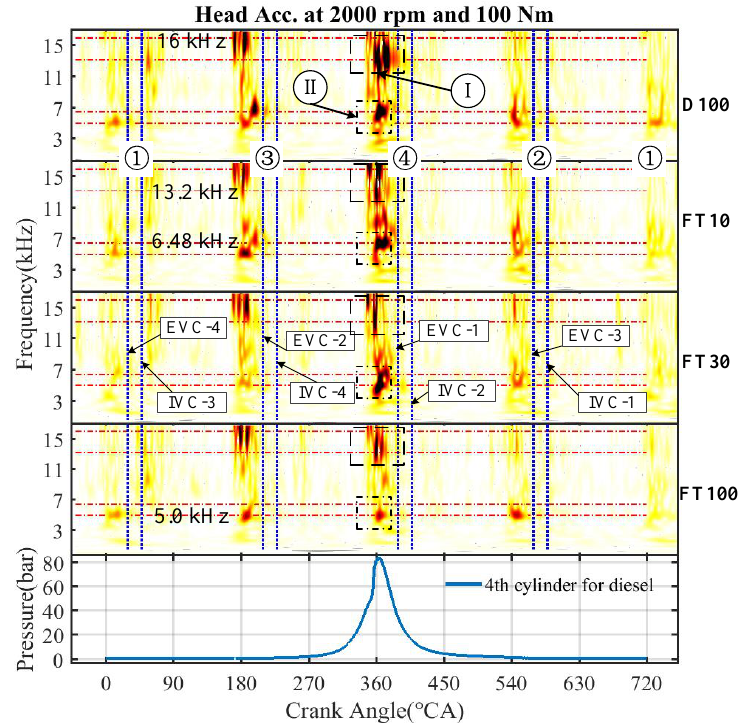
Figure 9. CWT transformation of engine head vibration signal.